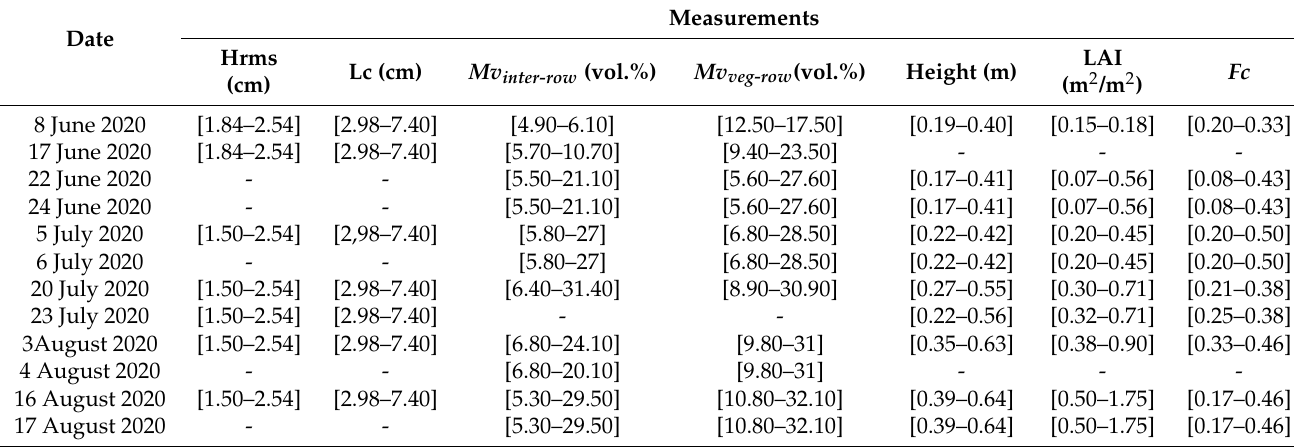
Table 2. The minimum and maximum values of in situ measurements during the data gathering campaign in 2020. Root mean square surface height Hrms, correlation length Lc, soil moisture Mv (inter-row soil moisture Mv inter - row and vegetation-influenced moisture Mv veg - row ) and pepper parameters (height, Leaf Area Index (LAI), and cover fraction ( Fc